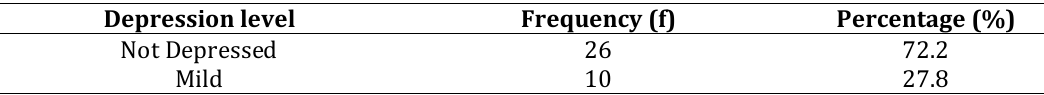
Level of depression after life-review therapy